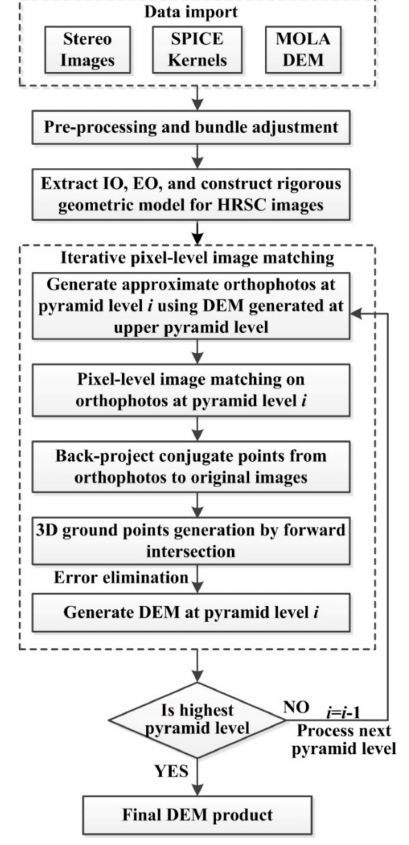
Figure 9. The digital elevation model (DEM) generation procedure using the proposed pixel-level image matching method. IO: interior orientation; EO: exterior orientation; SPICE: Spacecraft, Planet, Instrument, C-Matrix,